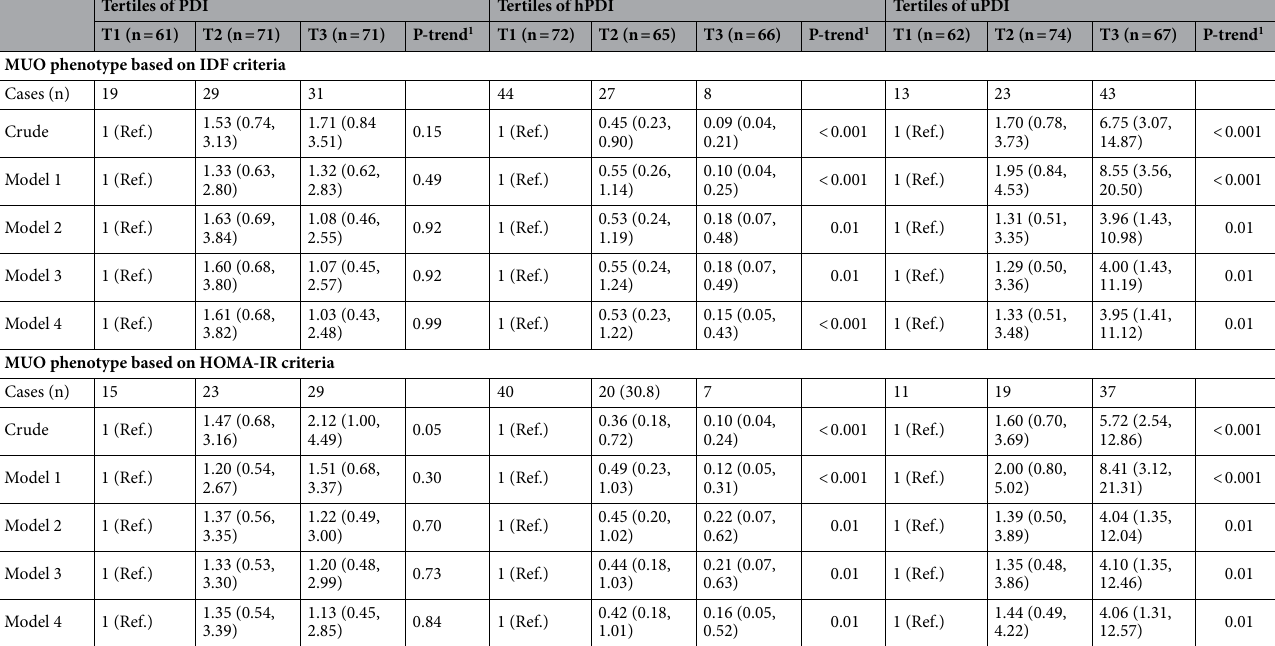
Table 3. Multivariate adjusted odds ratio (OR) and 95% confidence interval (CI) for MUO phenotype across tertiles of PDI, hPDI and uPDI. All values are odds ratios and 95% confidence intervals. Model 1: Adjusted for age, sex, and energy intake. Model 2: Additionally, adjusted for physical activity and socioeconomic status (evaluated based on parental education level, parental job, family size, having car in the family, having computer/laptop, having personal room and having travel by using demographic questionnaire). Model 3: Additionally, adjusted for margarine and trans fatty acids. Model 4: Additionally, adjusted for Body Mass Index (BMI). 1 Obtained by the use of tertiles of PDI, hPDI, or uPDI as an ordinal variable in the